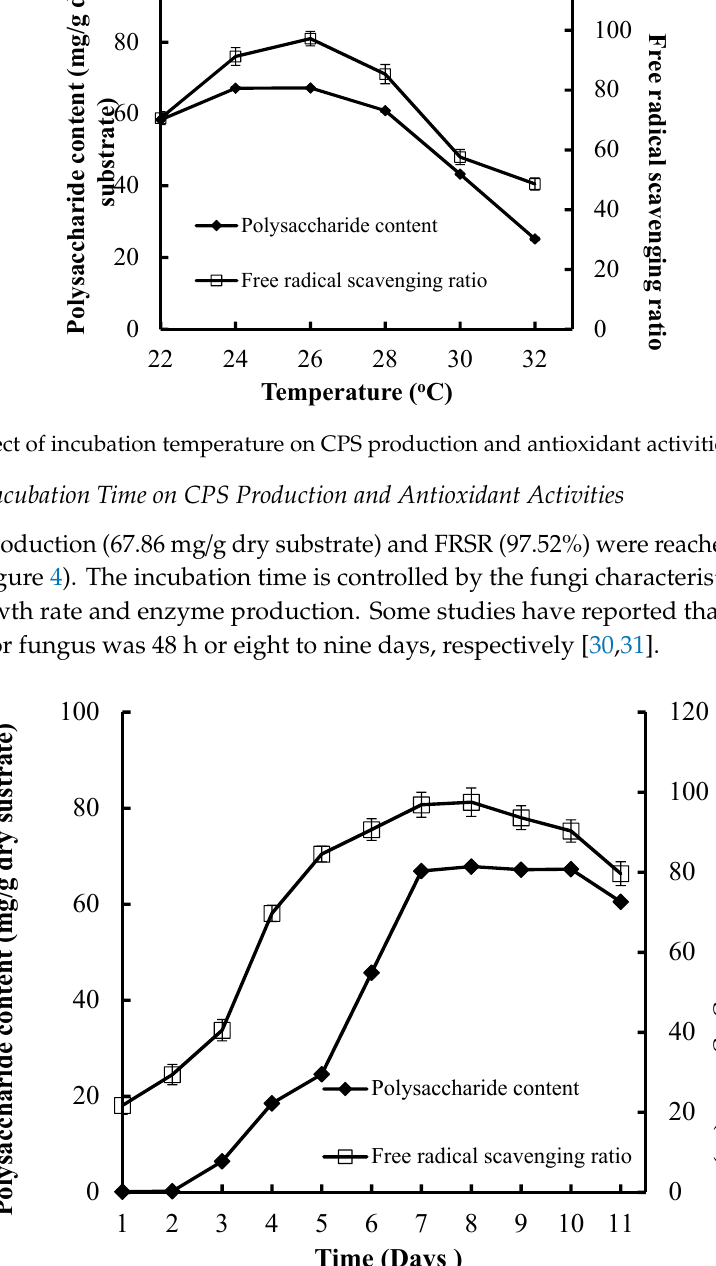
Figure 2. Effect of rice weight on CPS production and antioxidant activities of substrate.